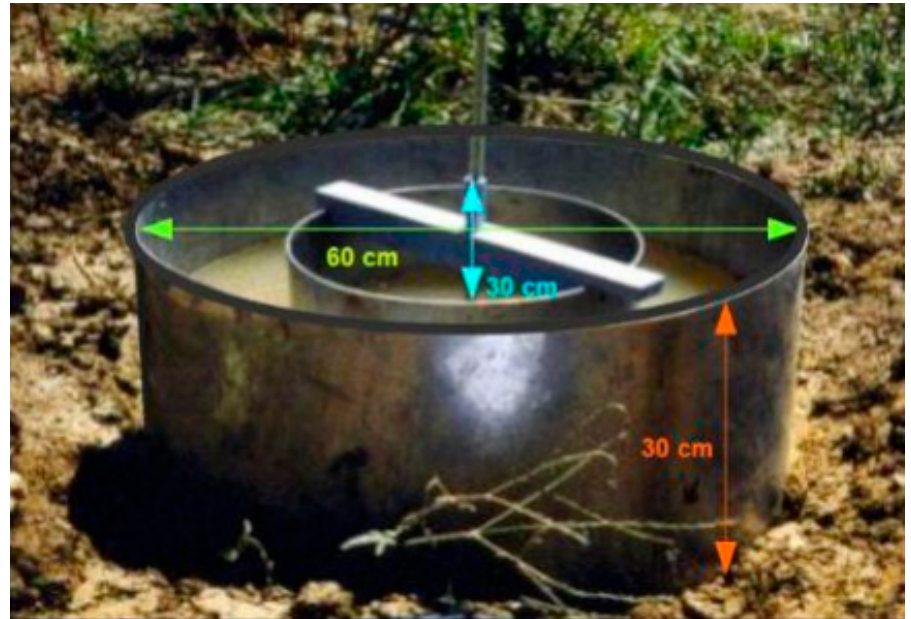
Figure 3. Experimental double rings infiltrometer. Table 2. Initial and final infiltration rates for Madjez Ressoul catchment.